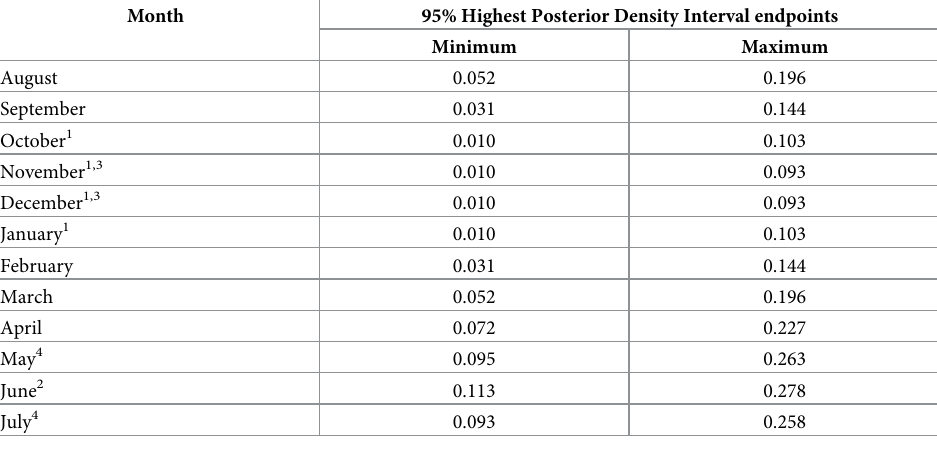
1 and 2 months have 95% HPDIs that do not overlap. 3 and 4 months have 95% HPDIs that do not overlap.